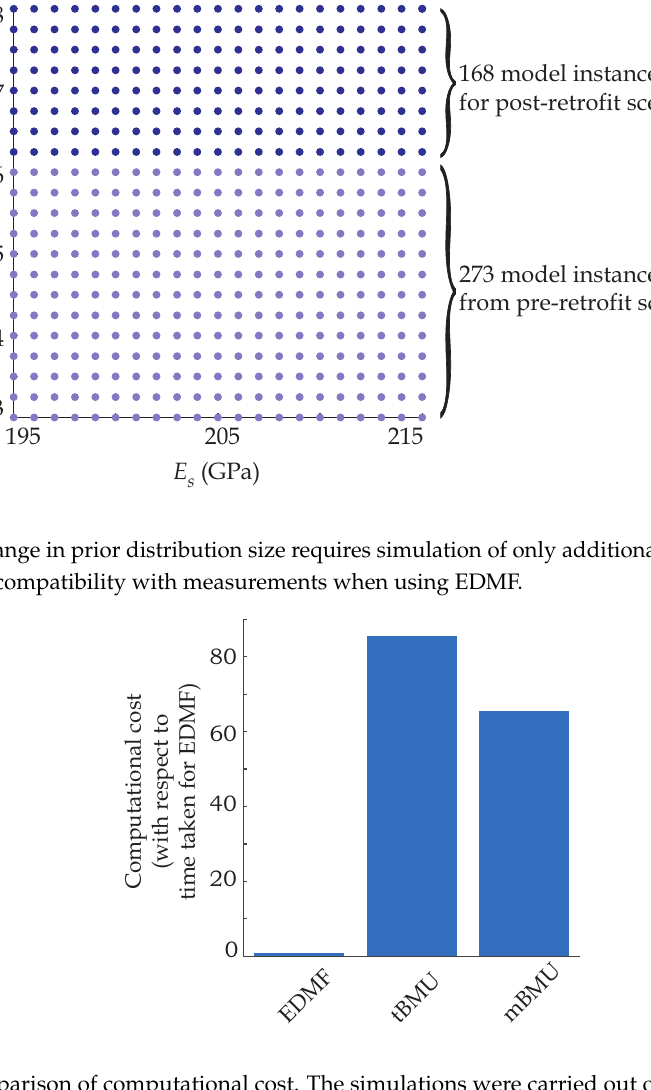
Figure 9. Comparison of computational cost. The simulations were carried out on a Intel(R) Xeon(R) CPU X5650 @2.67GHz processor with 24